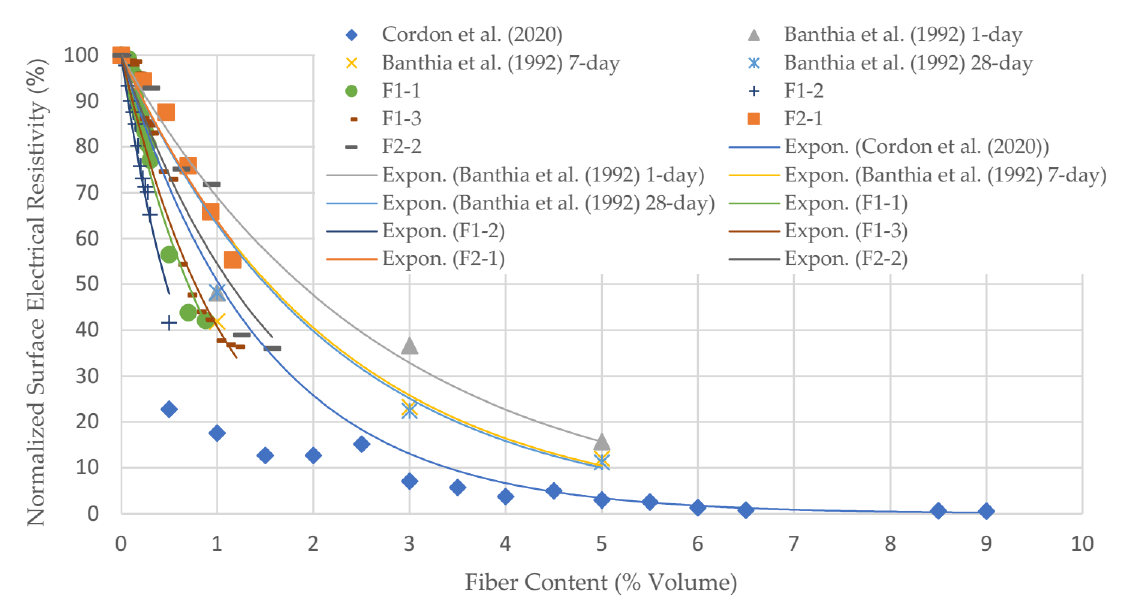
Figure 12. Comparison of the results of numerical and experimental experiments